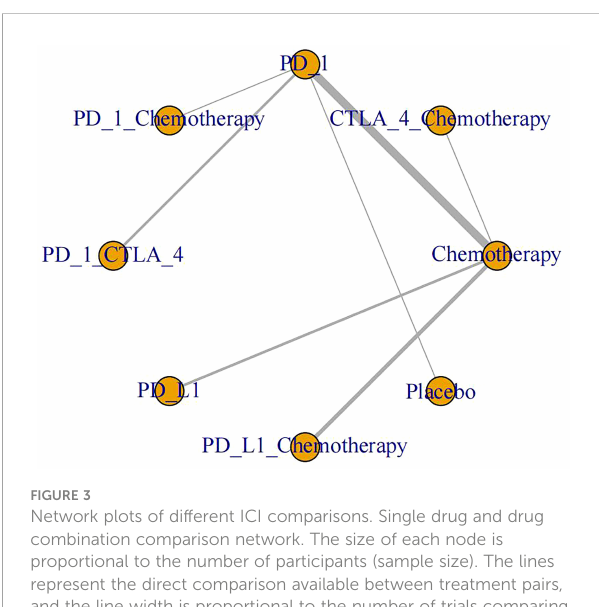
patients. Table 3 shows the speci fi c rates of cardiotoxicity for different treatment combinations.